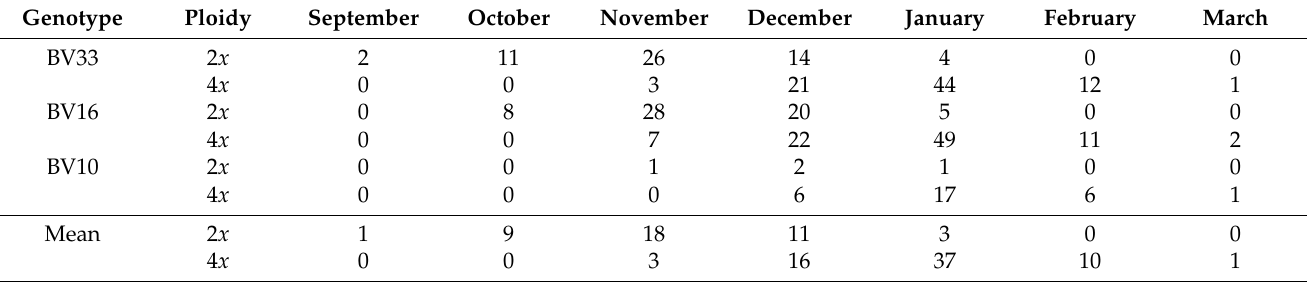
Table 3. Monthly flowering intensity a of diploid (2 x ) and tetraploid (4 x ) A. hybrid genotypes in the Bau Bang field trial. Genotype